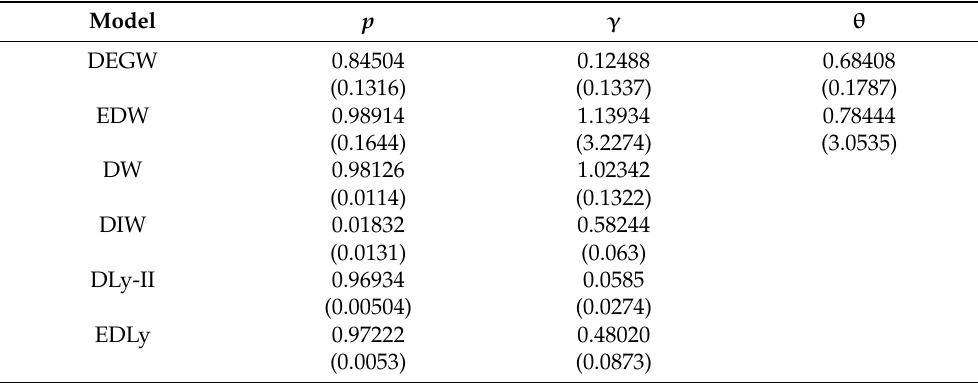
Table 13. The MLEs (and their corresponding St.Ers) for dataset